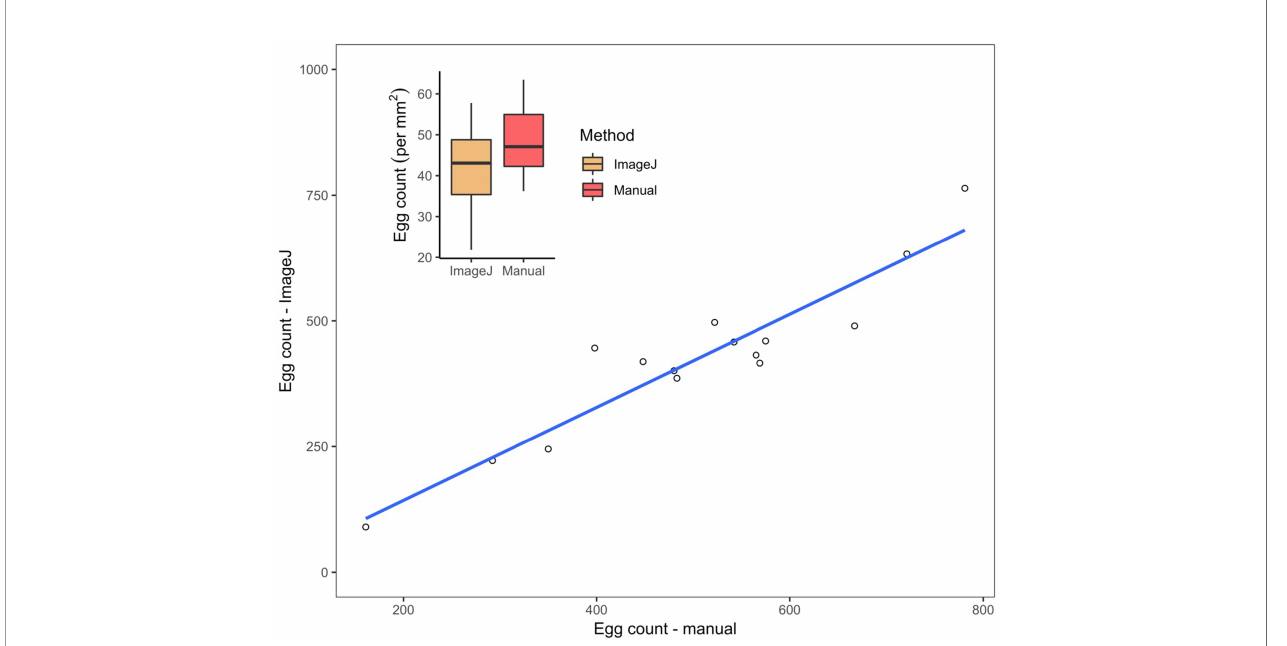
FIGURE 5 | Estimated counts of eggs within L. h. antarctica egg masses ( n =16). Linear regression from the correlation calculated between manual and semi- automated counts obtained through Fiji/ImageJ is y = 0.9787x – 55.9883, where y is the predicted number of eggs estimated through automation, and x is manual count variable; R 2 = 0.9217, p <0.05. Dashed line is 1:1 reference. Inset plot: Results of L. h. antarctica egg counts mm -2 conducted by automation and manually. Median values of egg counts per egg mass area are depicted by horizontal lines within the 50% interquartiles (boxes). Upper and lower vertical lines, or “ whiskers ” refer to maximum and minimum dependent values, respectively. No signi fi cant difference was observed between methods, p >